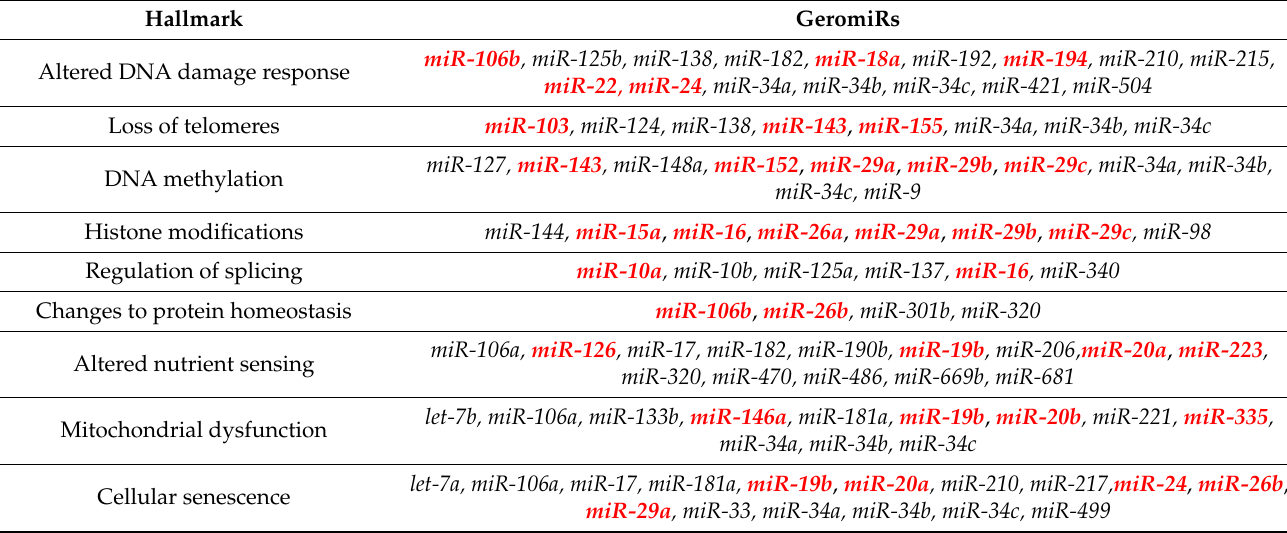
Table 2. Functional classification of geromiRs compiled from three review articles that are represented in the used microarrays. The significantly downregulated geromiRs are in bold